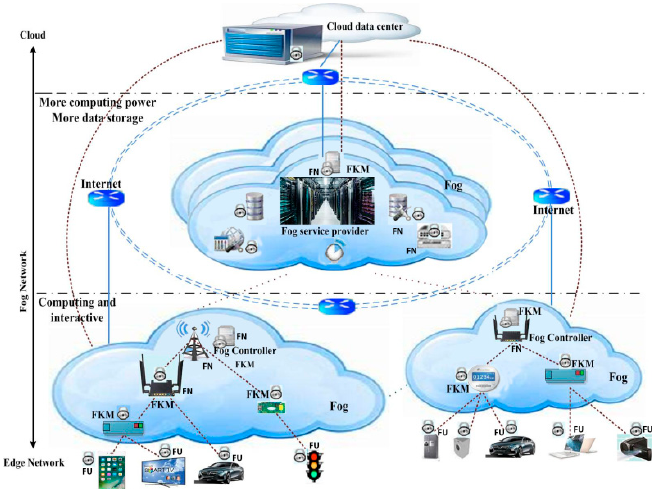
Figure 1. Network model of fog structure.